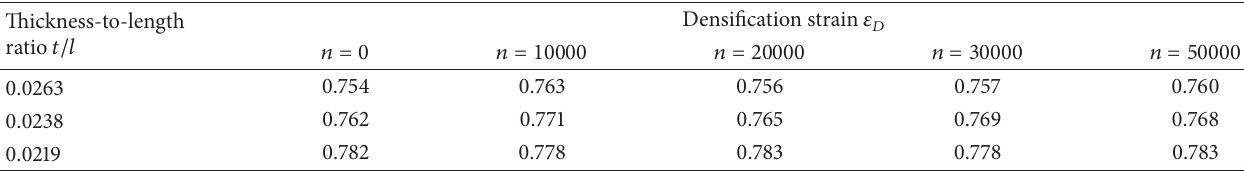
Table 3: Densification strains of honeycomb paperboard under various FD (23 ∘ C).